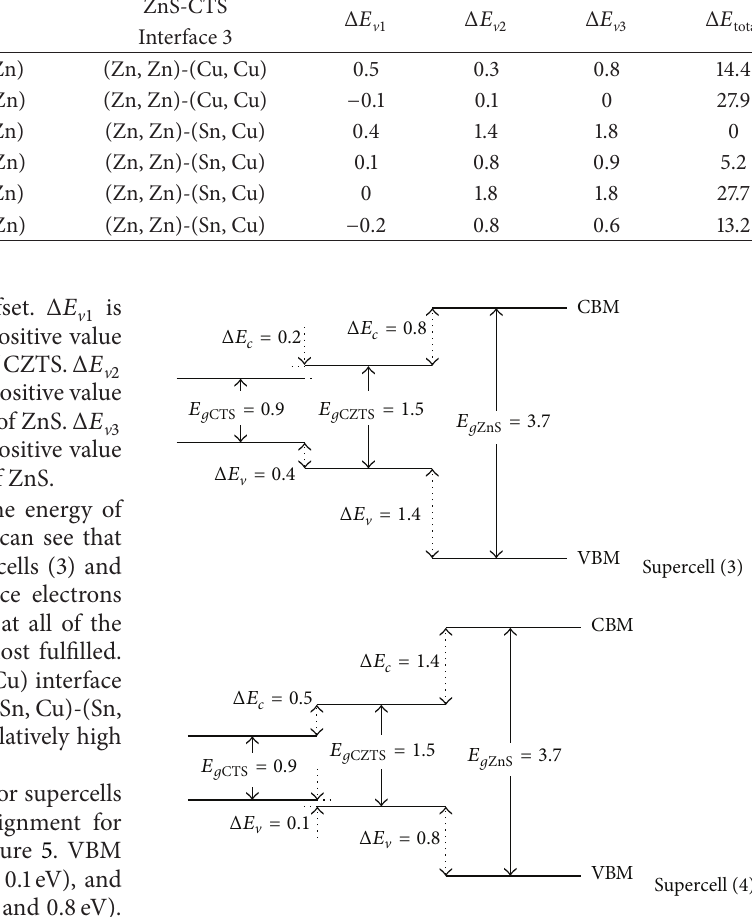
Figure 5: Predicted band alignments for supercell (3) and supercell (4) of